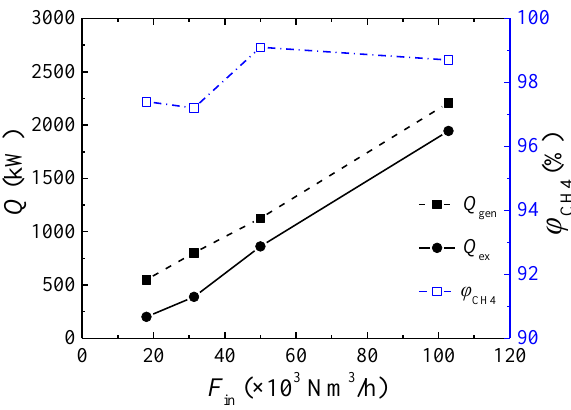
Figure 9. Heat generated by methane reaction ( Q gen ), heat loss of exhaust gas ( Q ex ) and methane conversion ( φ CH4 ) during self-maintained operation with different inlet flow rates ( F in ).